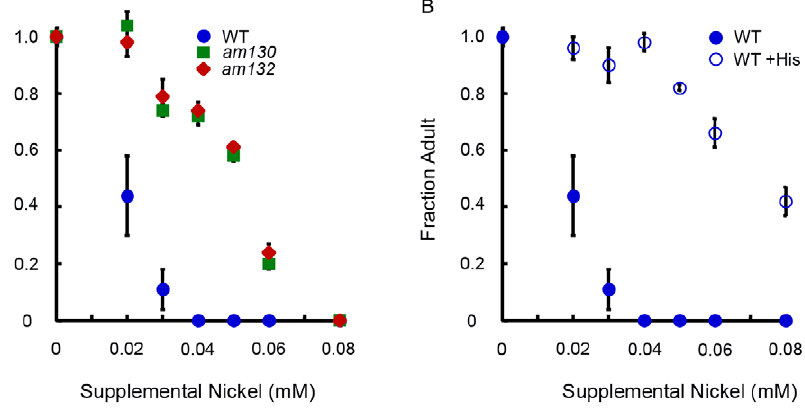
Figure 7. haly-1 mutations and dietary histidine cause resistance to dietary nickel. (A) Wild-type, haly-1(am130) , and haly-1(am132) hermaphrodites were synchronized at the L1 stage and cultured on NAMM supplemented with nickel (mM). The fraction of worms that grew to adulthood over seven days was monitored; the data were normalized by setting the value at 0 mM supplemental nickel equal to 1.0. Each point indicates mean value 6 SE (n=6 replicates with 50 worms per replicate). The fraction adult for haly-1(am130) and haly-1(am132) was significantly higher than wild type at 0.02–0.06 mM supplemental nickel (p , 0.01). (B) Wild-type animals were cultured with no histidine (closed circles) or with 0.1 mM L-histidine (open circles). Each point indicates mean value 6 SE (n=6 replicates with 50 worms per replicate). The fraction adult for WT + His was significantly higher than WT at 0.02 mM and higher concentrations of supplemental nickel (p , 0.01). doi:10.1371/journal.pgen.1002013.g007 PLoS Genetics |